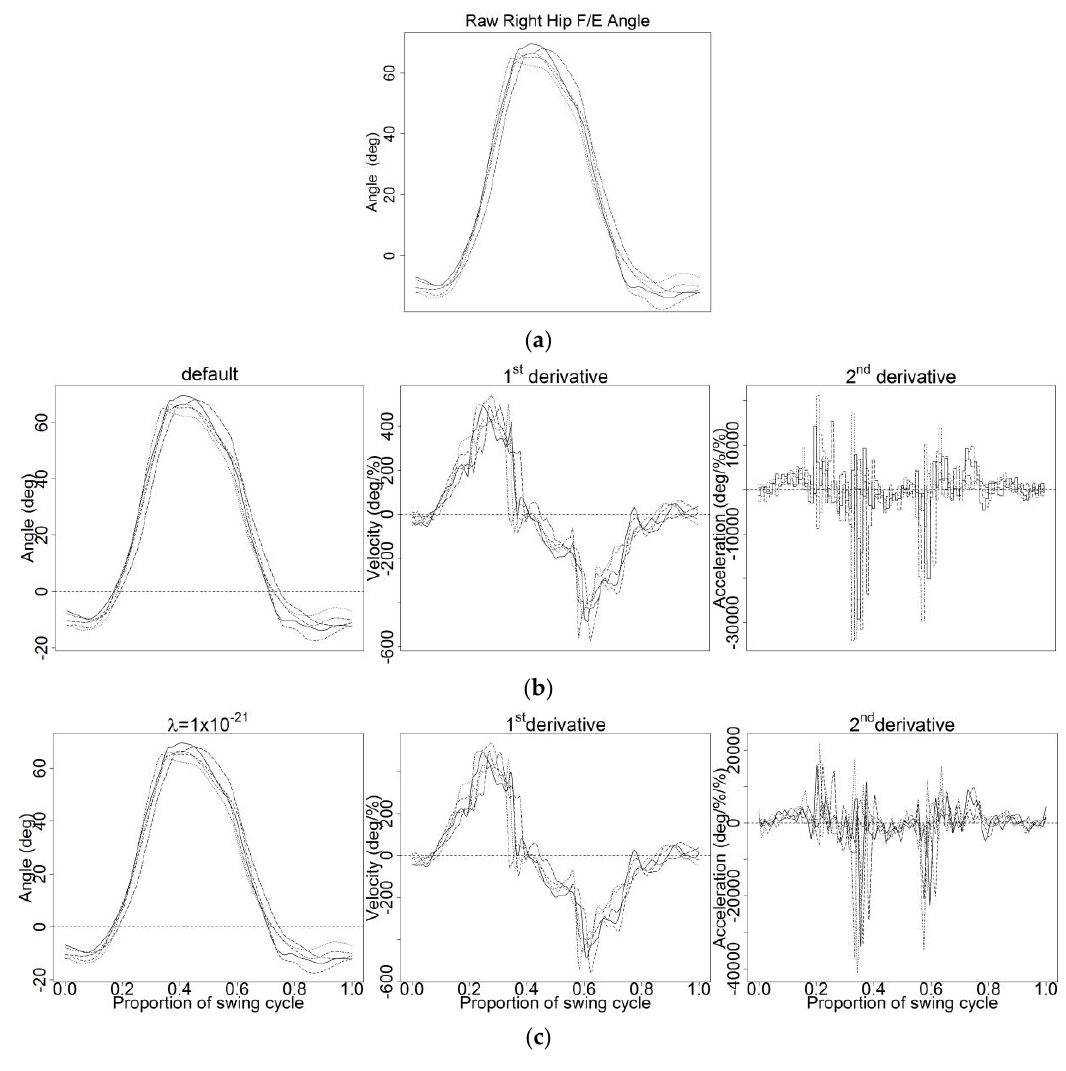
Figure 2. ( a ) Raw right hip flexion / extension (F / E) angle in a discrete form during American kettlebell swing (AKS), ( b ) functional data object by default, and ( c ) λ = 1 × 10 − 21 with their first and second derivative